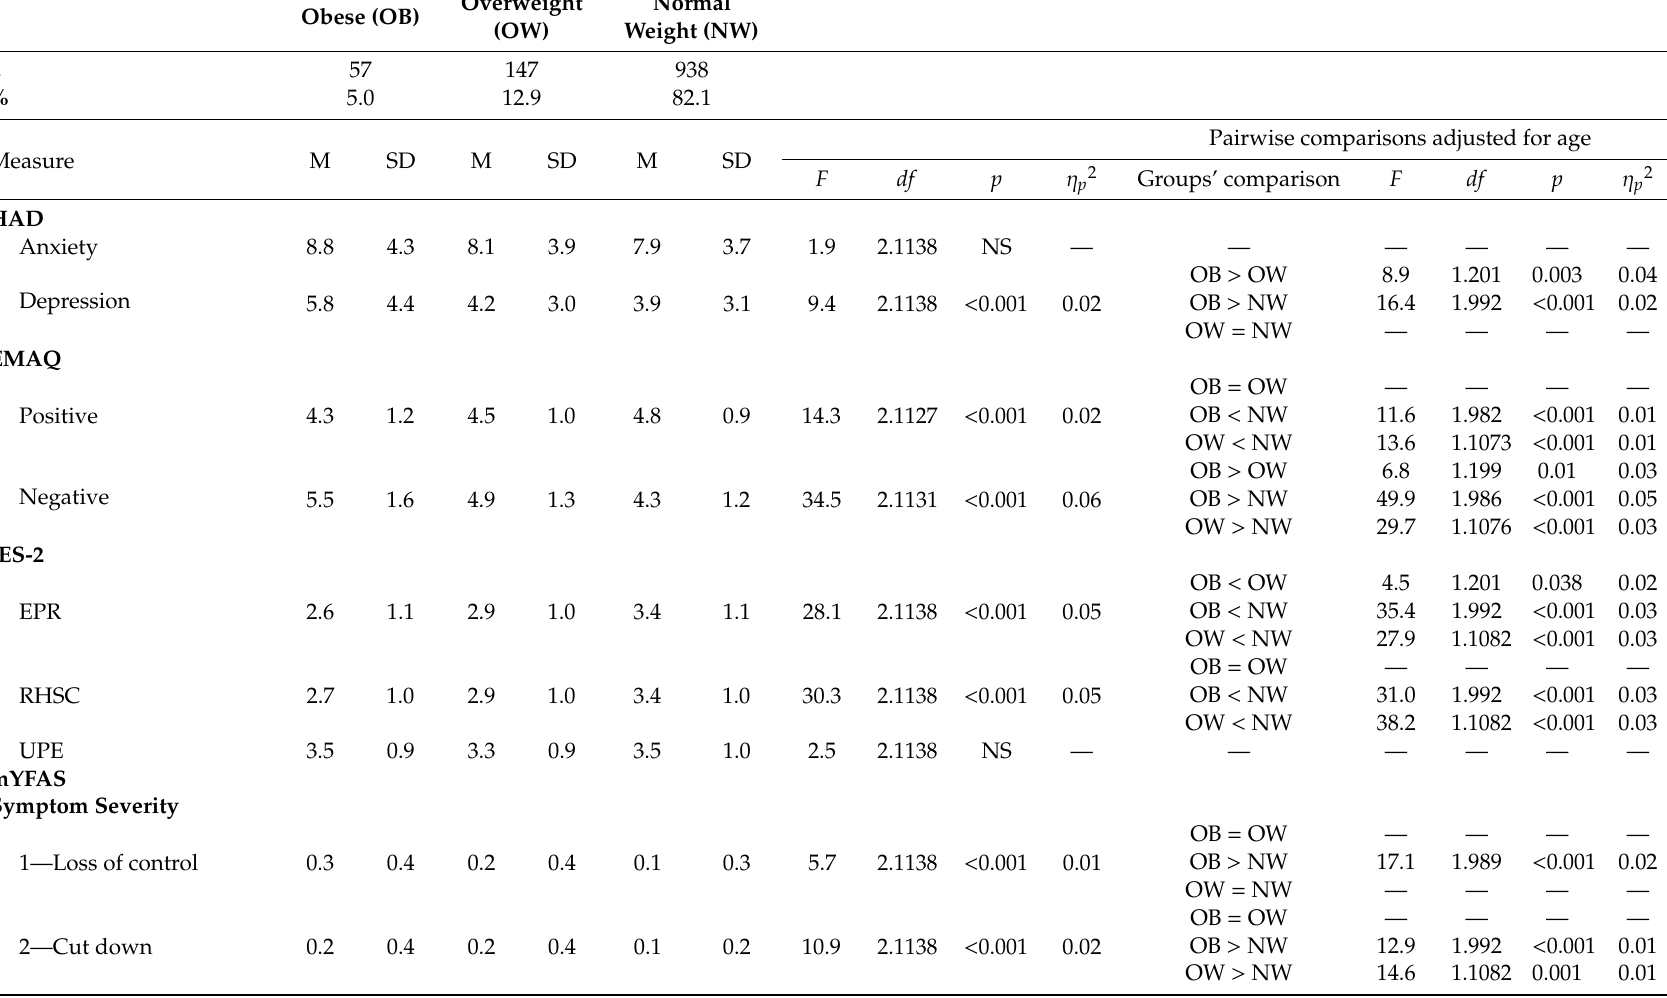
Table 2. BMI group